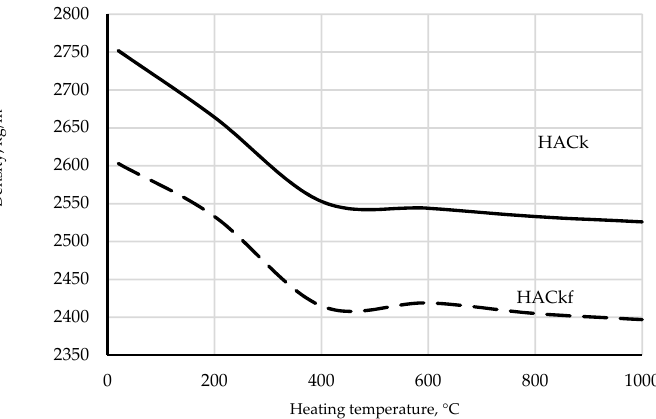
Figure 9. Change in density of HACk and HACkf concretes.